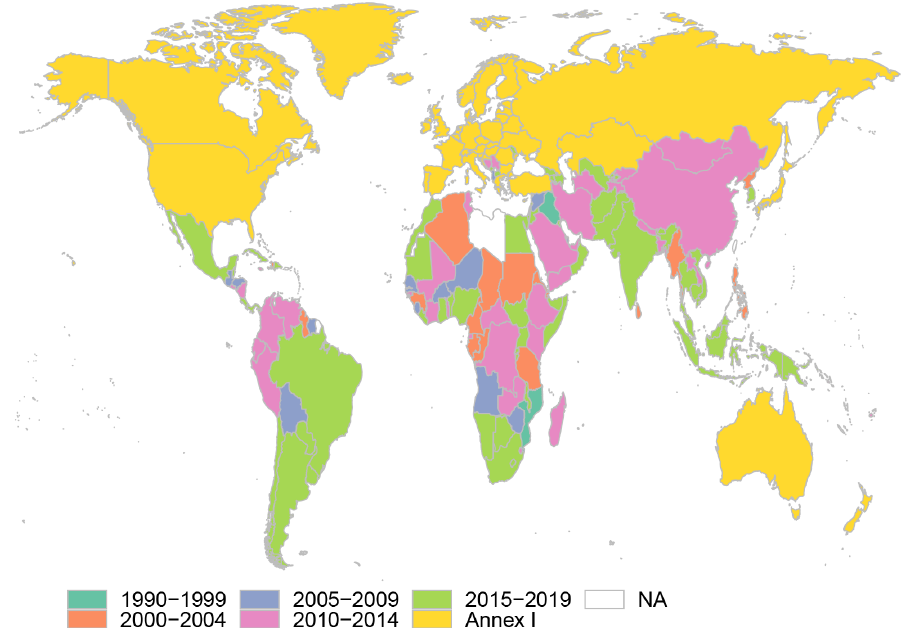
Figure 9. Overview of the most recent GHG emissions inventories submitted to the UNFCCC: the map captures the last year for which emission inventories were conducted and published by the UNFCCC on their website (as of 28 September 2021), including CRFs, BURs, and NCs. Annex I countries, according to the UNFCCC definition, have reported their last inventories for 2019 (UNFCCC, 2021). Updated from Janssens-Maenhout et al.